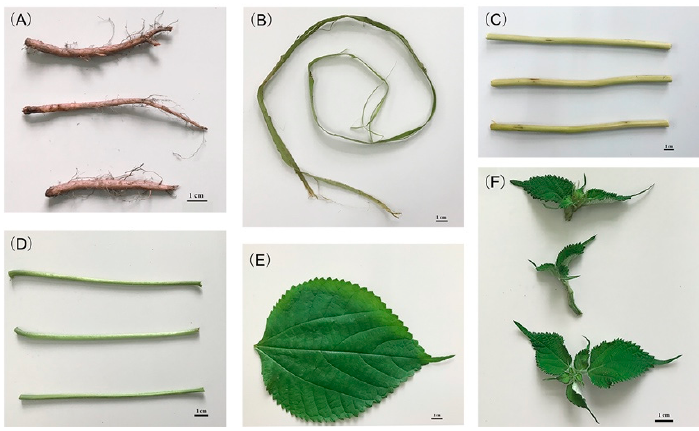
Figure 1. The photos of different vegetative parts including (A) root, (B) xylem, (C) phloem, (D) petiole, (E) leaf, and (F) bud from Boehmeria nivea L.